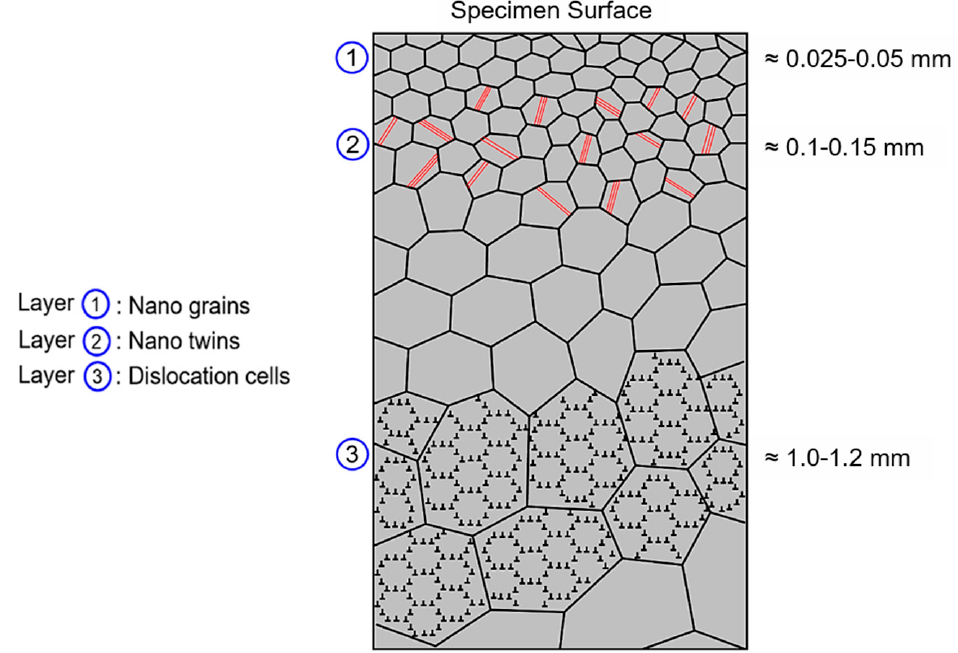
Figure 6. Schematic of the cross-sectional microstructure of the SMAT processed SS 316L specimen consisting of a nanograin layer adjacent to the top surface, a nanotwin layer below the nanograin layer and a layer characterized by dislocation cells in the central region.